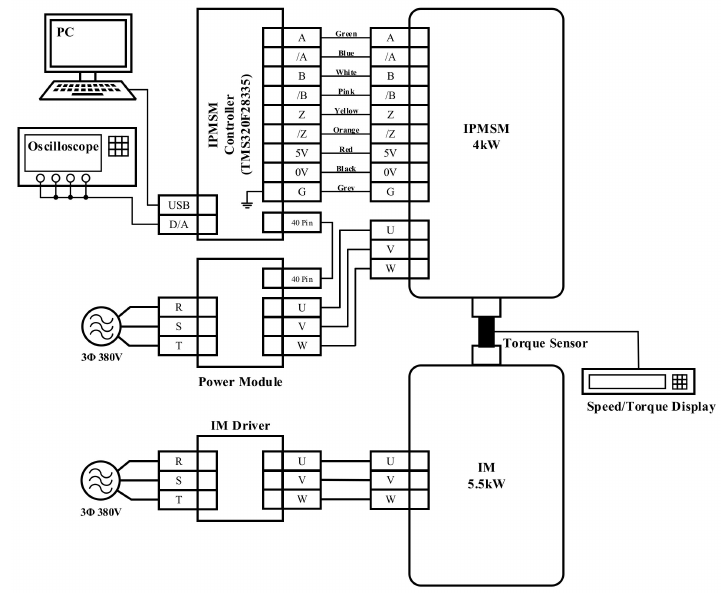
Figure 11. M-G set wiring diagram for